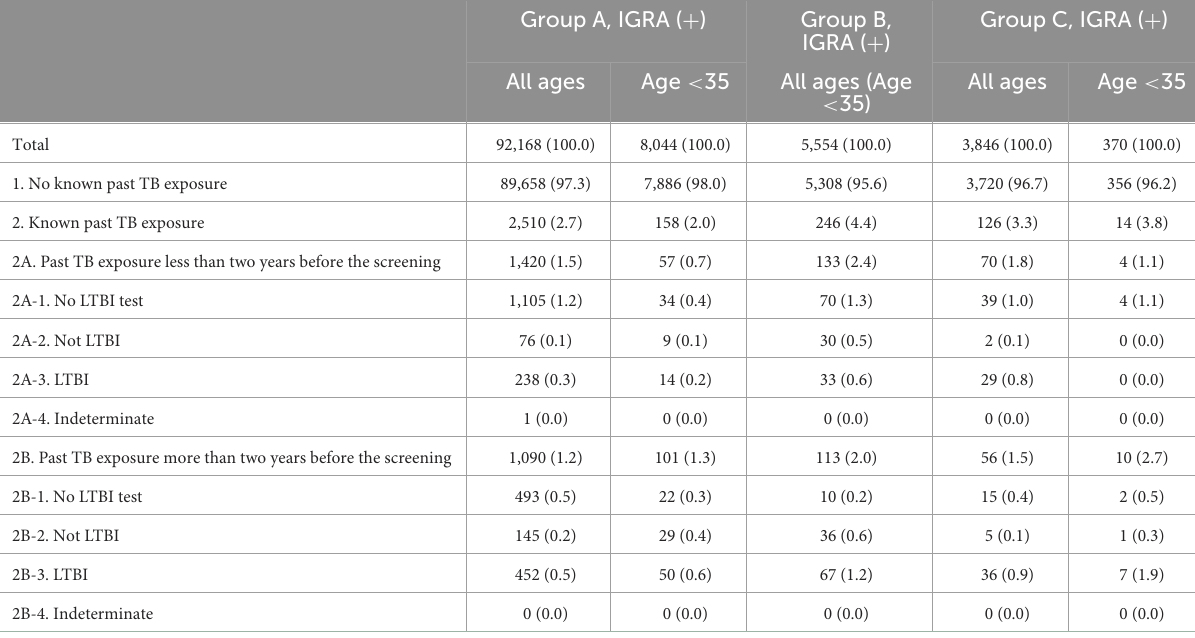
TABLE 5 Coverage rate of current LTBI strategy targeting for TB contacts among the participants with positive IGRA result in each group.